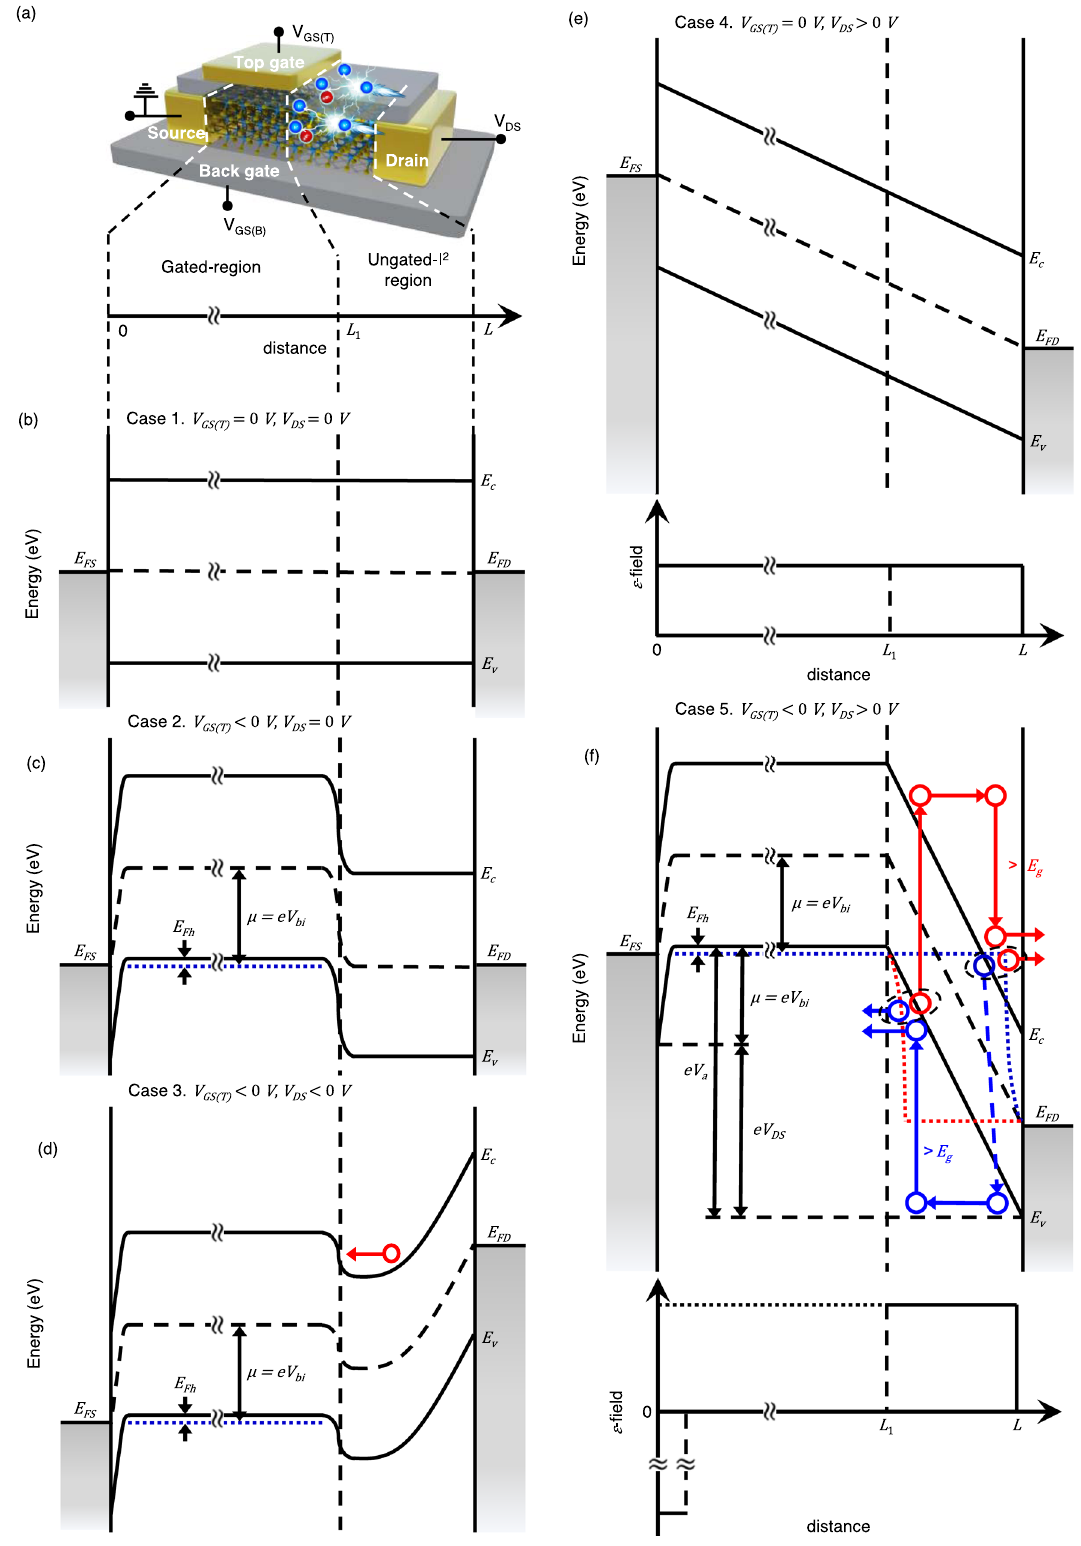
Fig. 1 | Devicestructureand energy band pro fi leofthe WSe 2 I 2 FET. a Schematic valence band energy, source fermi level, and drain fermi level, respectively, E FH : of the WSe 2 lateral impact ionization transistor. Energy band diagrams for each Fermi energy of highly doped hole gas, μ : chemical potential energy, E g : energy case: b V GS(T) =0V, V DS =0V, c V GS(T) < 0V, V DS =0V, d V GS(T) < 0V, V DS < 0V, bandgap, V a : potential energy drop in the avalanche region, L : total length of the e V GS(T) =0V, V DS >0V, and f V GS(T) < 0V, V DS >0V. Red and blue circles represent channel, L 1 : boundary between the gated region and the ungated region, and V bi : electrons and holes, respectively. V GS(T) and V GS(T) : topgate and back-gate voltage, built-in potential at the boundary between the gated and ungated regions). V E E E E I DS and DS :draincurrentandvoltage. C , V , FS ,and FD :conductionbandenergy,